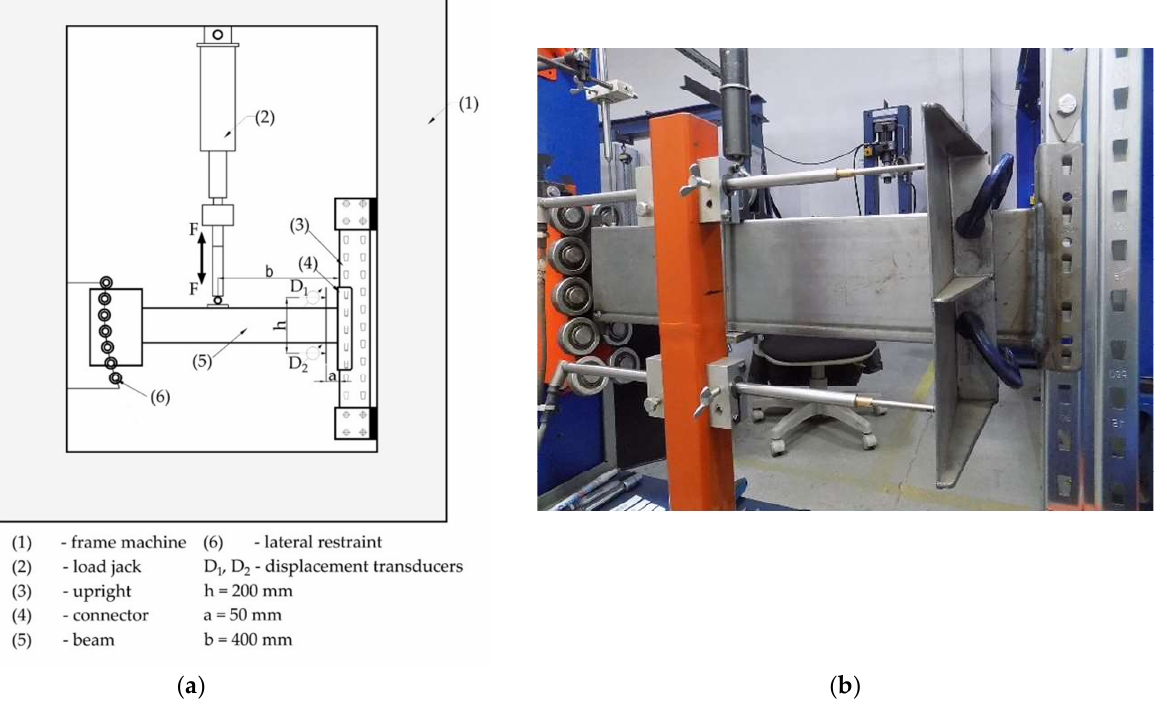
Figure 5. Experimental test setup for bending test and looseness test according to European standard EN 15512: ( a ) scheme of the test stand; ( b ) photo of the test stand.